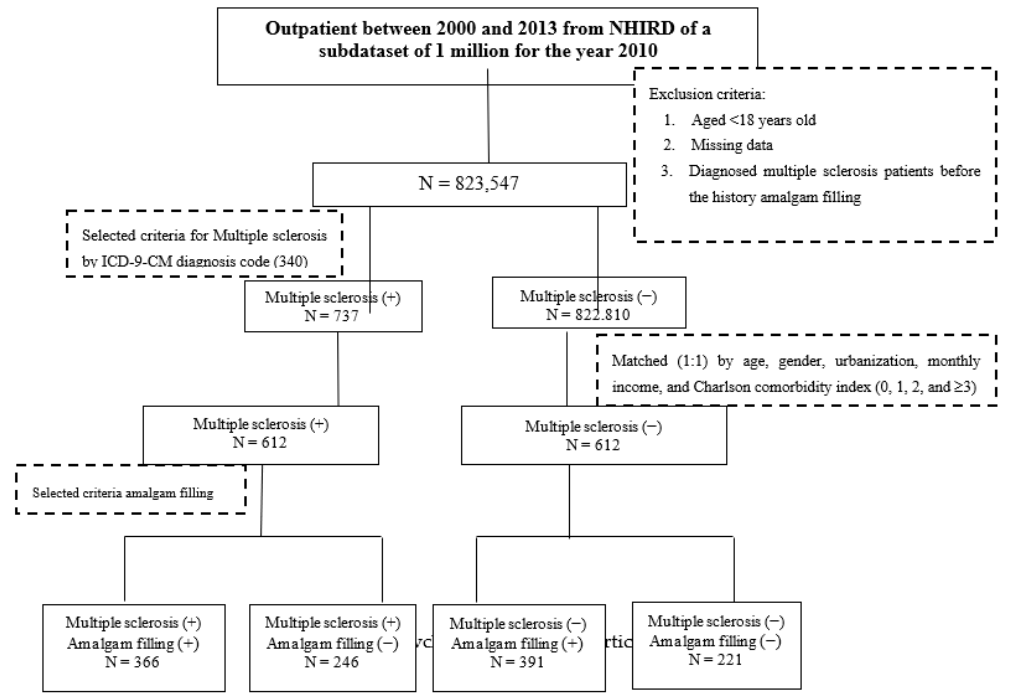
Figure 1. Procedures used for selection of cases from the Longitudinal Health Insurance Database 2010.